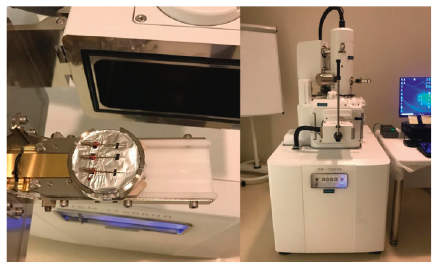
Figure 1: Laboratory setup for SEM